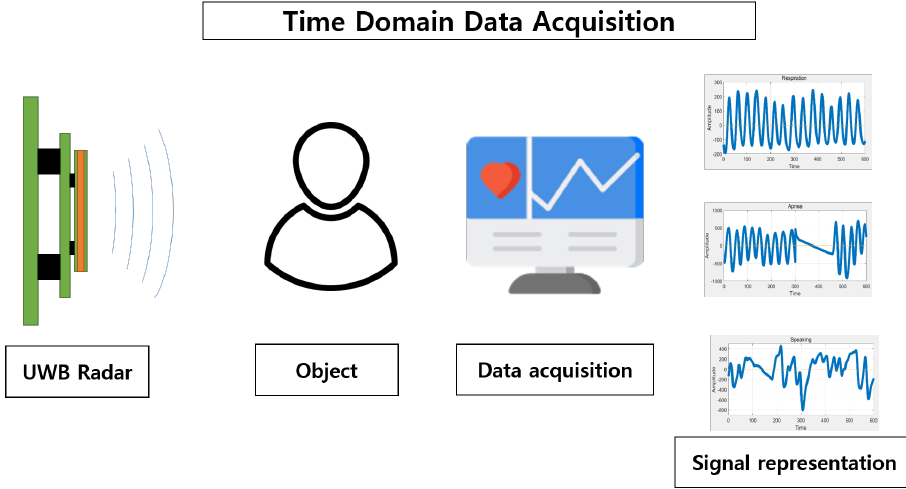
Figure 9. The process of obtaining a respiratory state signal using the UWB